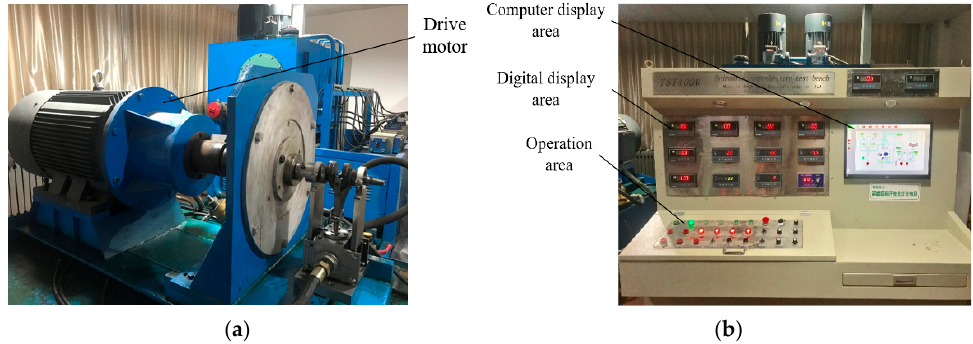
Figure 14. Hydraulic comprehensive experiment bench (HCEB). ( a ) Workbench; ( b ) Console.